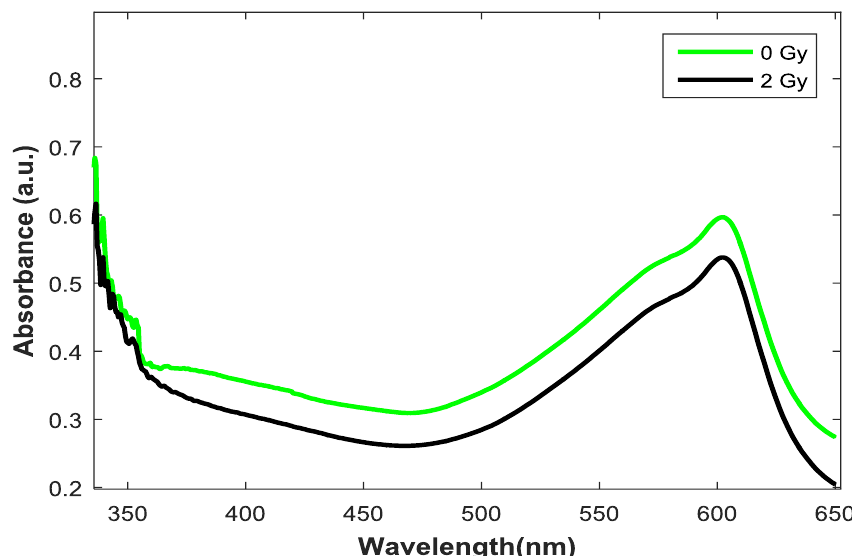
Fig. 5. Absorption-wavelength curve of GENIPIN gel read by spectrophotometer Figure 5 : Absorption-wavelength curve of GENIPIN gel read by spectrophotometer